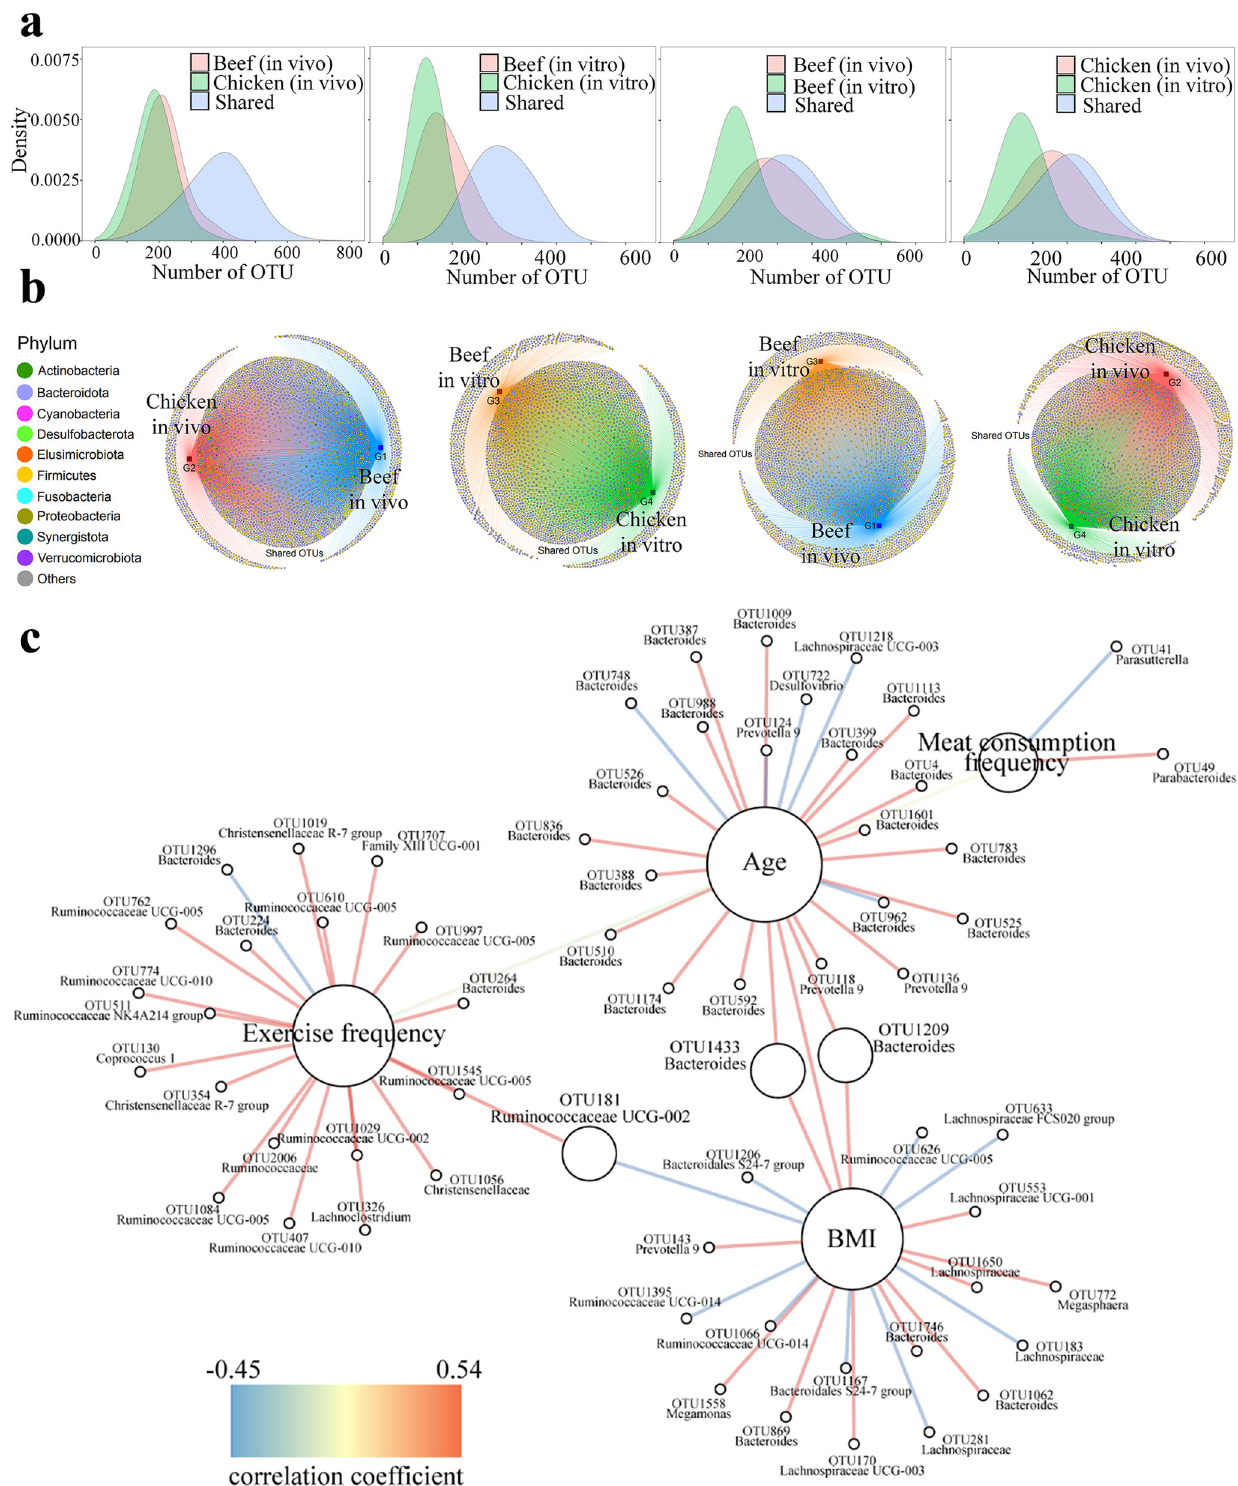
Fig. 3 Comparison of the fecal microbiota in response to meat-based diet alteration or digests of meat proteins. a density distribution plot; b network plot at the phylum level; and ( c ) correlation analysis between volunteers ’ indexes (age, exercise, BMI and meat consumption frequency) and fecal microbiota, the color scale indicates the Spearman correlation coef fi